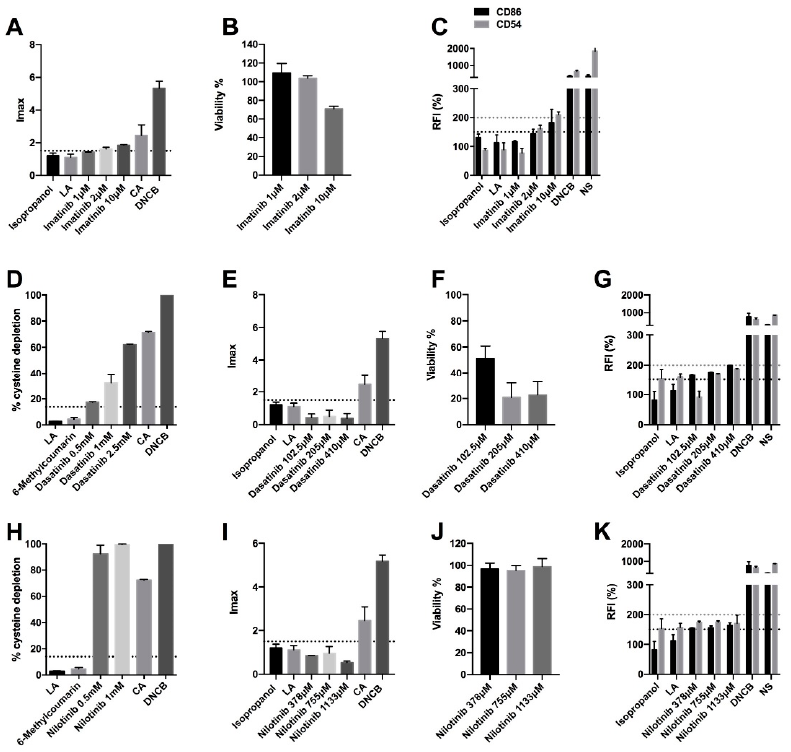
Figure 2. Analysis of delayed-type hypersensitivity of imatinib, dasatinib, and nilotinib by direct peptide reactivity assay (DPRA), KeratinoSens TM assay, and human cell line activation test